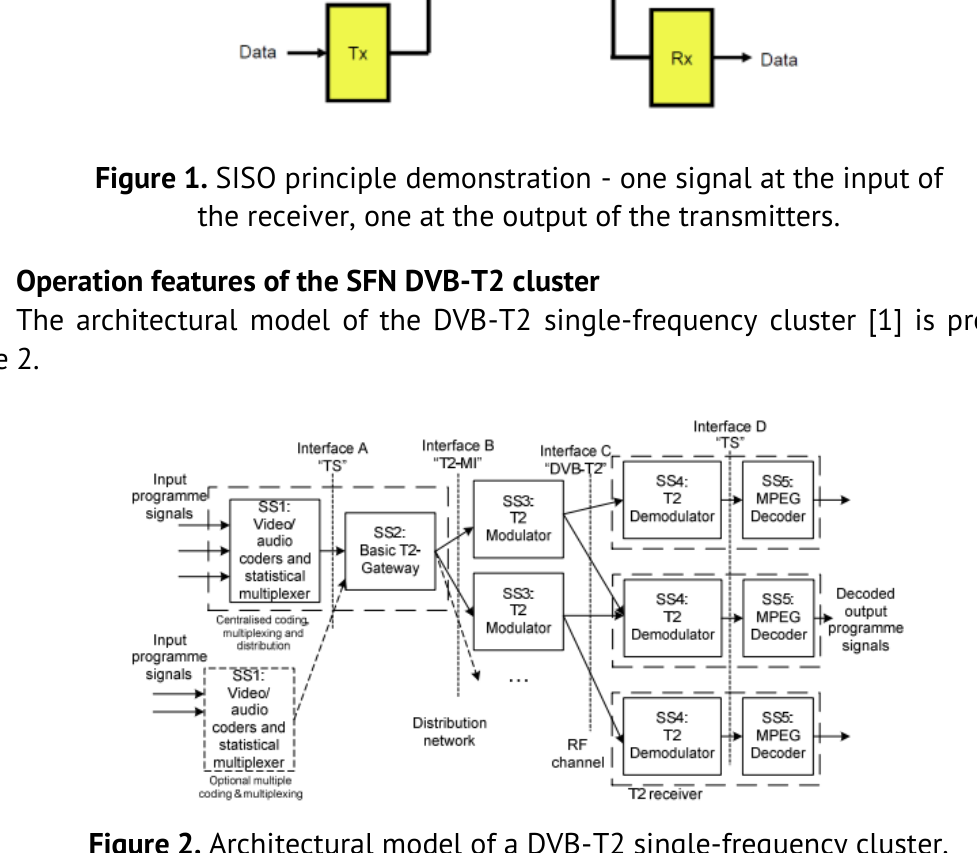
Figure 2. Architectural model of a DVB-T2 single-frequency